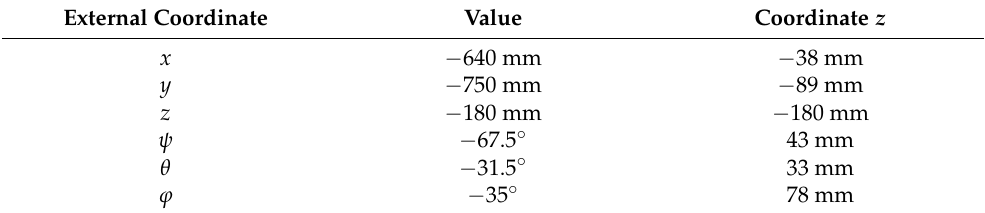
Table 8. Minimal values of external